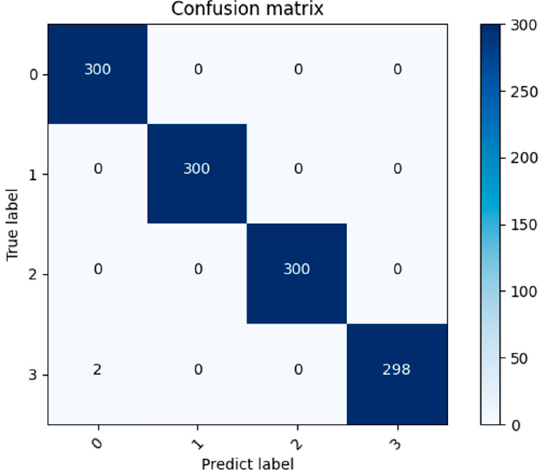
Figure 16. Confusion matrix of the SR-1DCNN model (test set of Worm Gear Reducer).